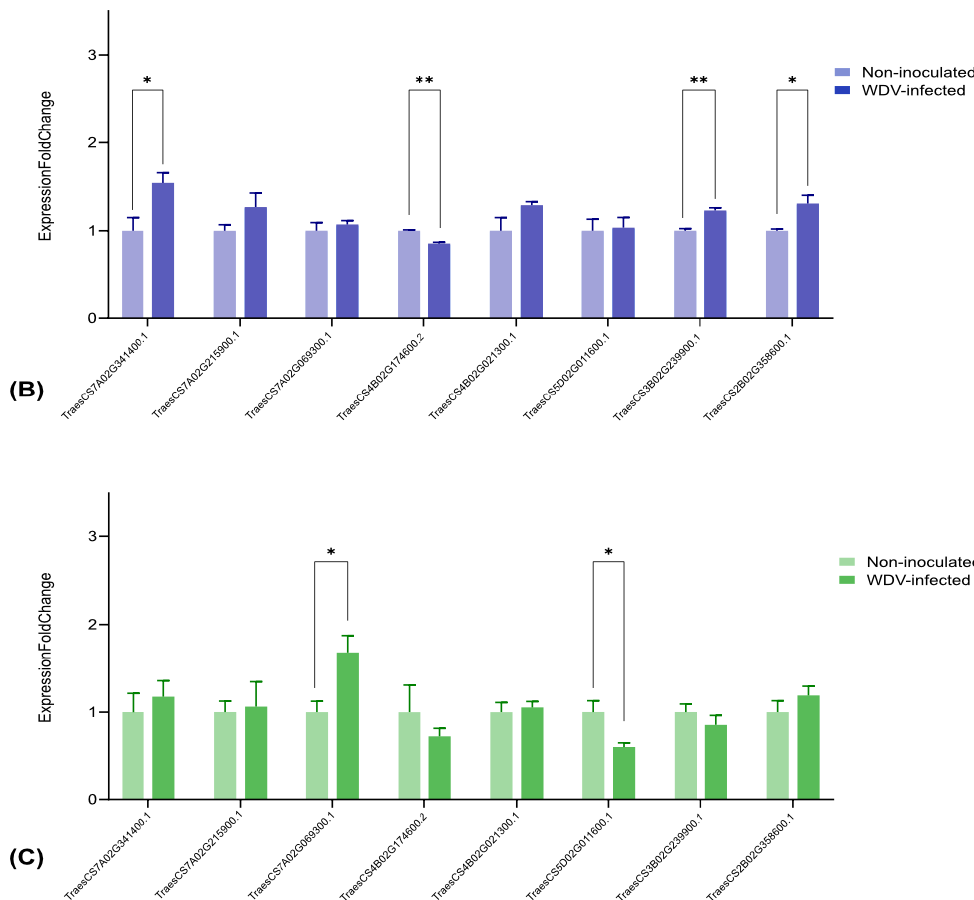
Figure 6. RT-qPCR analyses of eight WDV infection-related transcripts in WDV-infected and non- inoculated ( A ) Akteur, ( B ) Svitava and ( C ) Fengyou 3 genotypes. Each bar represents the mean ±